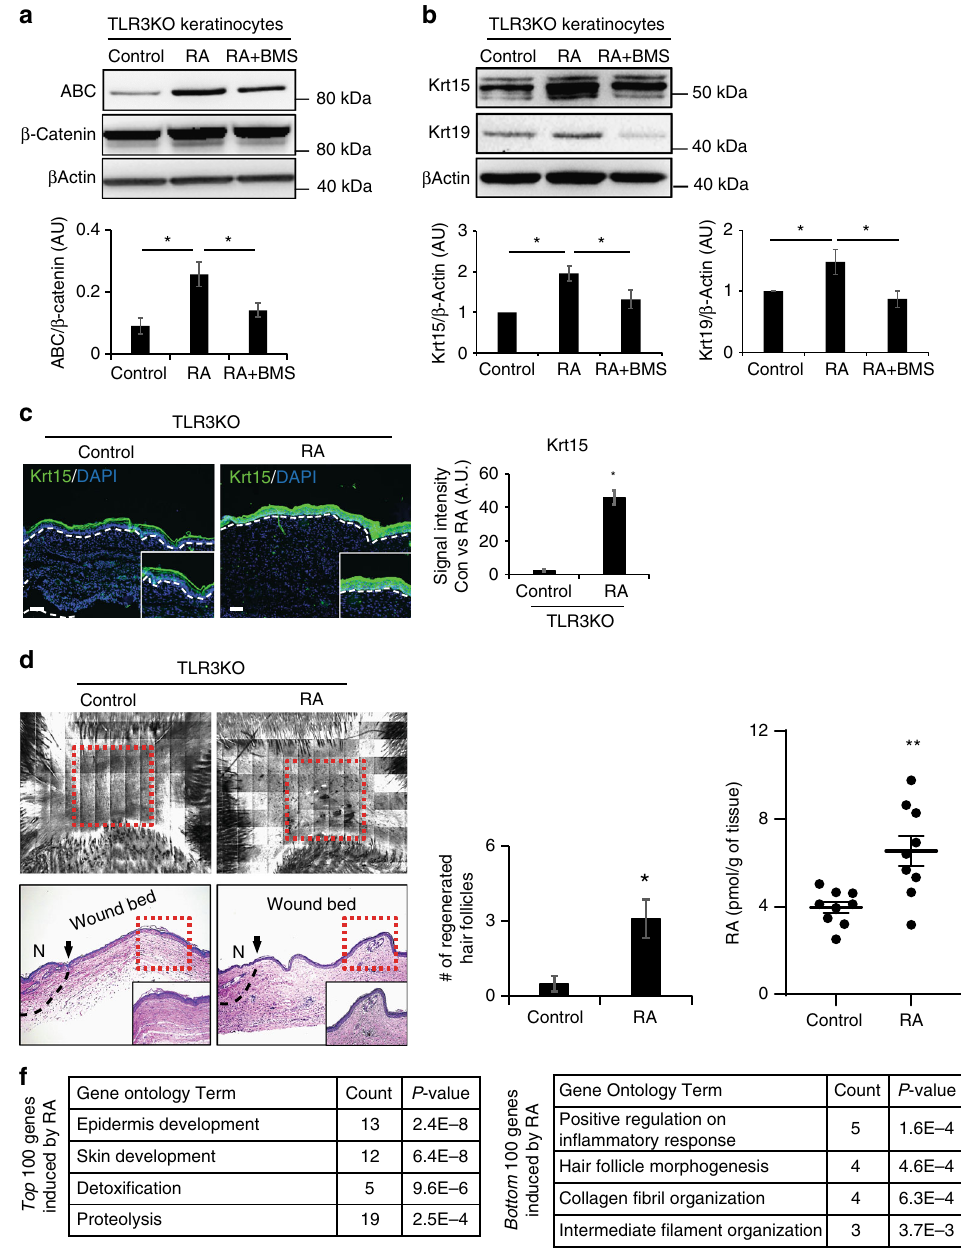
Fig. 3 RA induces keratinocyte stem cell markers and promotes WIHN in Tlr 3 − / − mice. a RA induces active β -catenin (ABC) expression in keratinocytes of Tlr 3 − / − mice, while the pan-RAR antagonist BMS493 inhibits induction. Representative western blot (top) and quantitation (bottom), normalized to total β -catenin. ( n = 3 independent experiments, * P < 0.05, paired Student t -test). b RA induces Krt15 and Krt19 expression in keratinocytes of Tlr 3 − / − mice, while BMS493 substantially inhibits expression. Representative western blot (top) and quantitation of Krt15 (bottom left) and Krt19 (bottom right), normalized to β -Actin. ( n = 3 independent experiments, * P < 0.05, paired Student t -test). c RA induces prominent Krt15 (green) in Tlr 3 − / − wounds as detected by immunostaining (left) and quantitated (right; n = 3 independent animals, *** P < 0.001, paired Student t -test). White dashed lines indicate basement membrane. Nuclei stained with DAPI (blue). White scale bar = 100 µ m. d RA induces WIHN in Tlr 3 − / − mice as detected by CLSM (top), H&E staining (middle) and quanti fi cation (right; n = 6 – 11 independent animals, * P < 0.05, unpaired Student t -test). Black arrows and dashed lines signify the boundary between unwounded and wounded area. Red dashed lines indicate area of WIHN. Black scale bar = 100 µ m. N; normal unwounded skin. e Exogenous RA treatment increases RA levels in Tlr 3 − / − mice ( n = 9 independent animals, ** P < 0.01, paired Student t -test). f Gene Ontology analysis of the top and bottom 100 transcripts after RA treatment to Tlr 3 − / − mice. Data are means± SEM mice displayed mostly intact hair follicle regeneration (Fig. 5f) RA synthesis in human keratinocytes that express both RAR α and whereas the homozygous Rar α null mice (Krt5-CreERT2-Rar α fl / RAR γ , but not RAR β 22,23 , we measured WIHN in keratinocyte- fl ) receiving vehicle or Poly (I:C) had a marked inhibition of hair targeted Rar α and Rar γ null mice (Krt5-CreERT2-Rar α fl / fl and Krt5-CreERT2-Rar γ fl / fl ). Keratinocyte-speci fi c Rar γ de fi cient follicle formation, compared to heterozygous mice (Fig. 5g). The